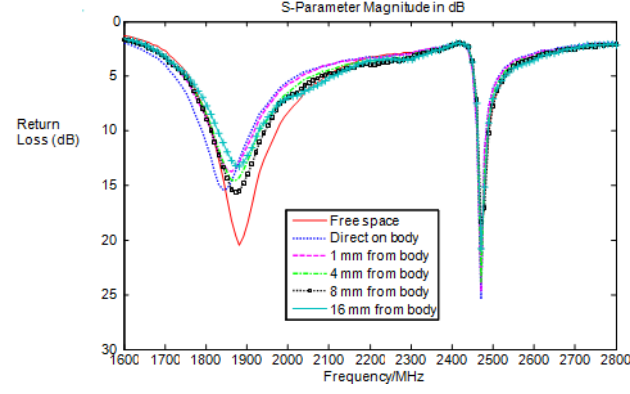
Figure 4. Measured free space and on-body return loss responses of the dual band